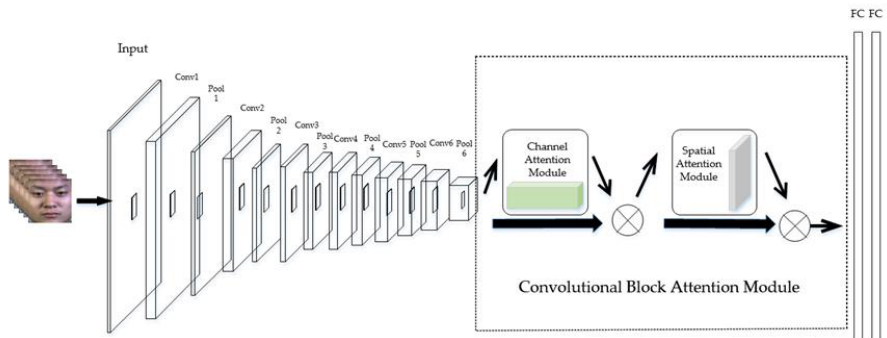
Figure 4. The overall structure of the proposed convolutional block attention module network (CBAMNet). The convolutional block attention module is shown within the dotted box.